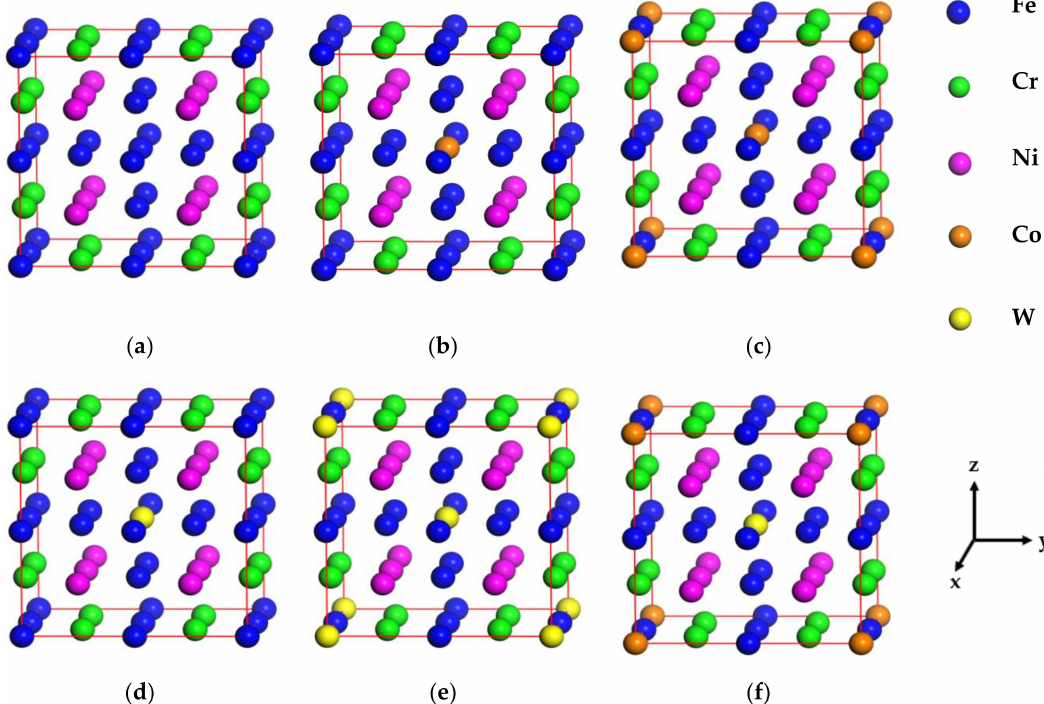
Figure 1. Schematic diagram of models for calculations: ( a ) Fe 16 Cr 8 Ni 8 ; ( b ) Fe 15 Cr 8 Ni 8 Co; ( c ) Fe 14 Cr 8 Ni 8 Co 2 ; ( d ) Fe 15 Cr 8 Ni 8 W; ( e ) Fe 14 Cr 8 Ni 8 W 2 and ( f ) Fe 14 Cr 8 Ni 8